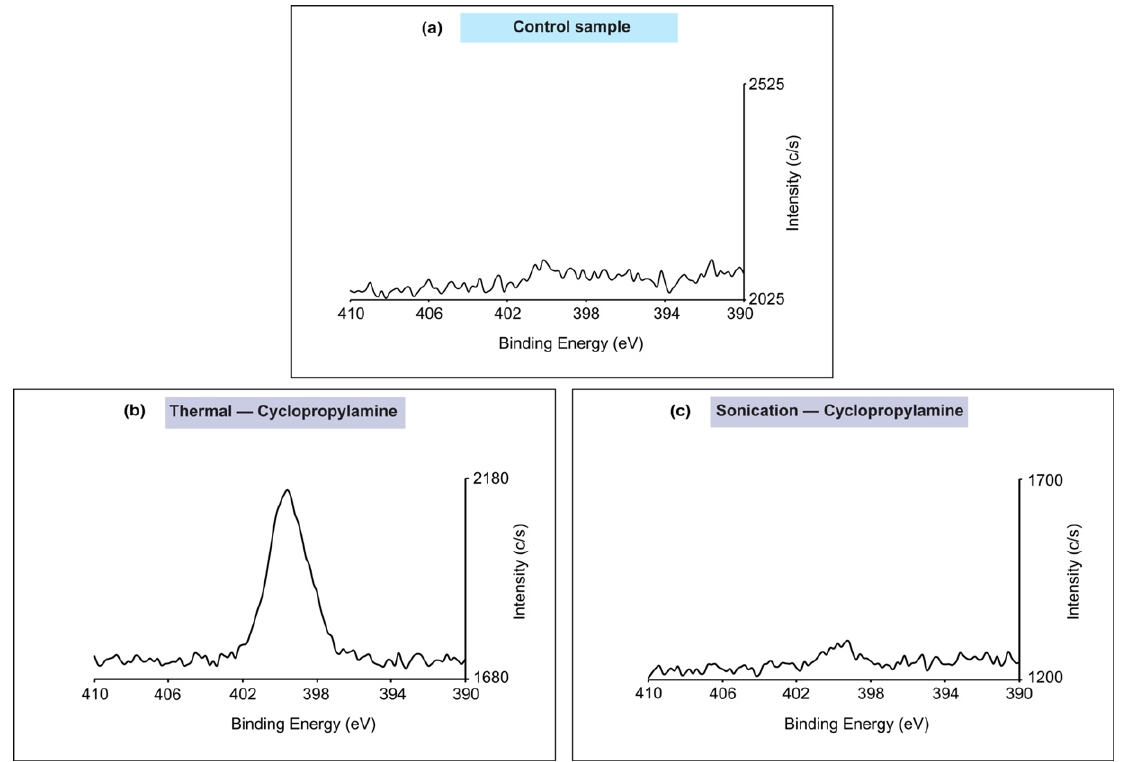
Figure 5. N1s spectra analysis for ( a ) control sample; ( b ) cyclopropylamine thermal reaction; ( c ) cyclopropylamine sonochemical reaction. Both samples ( a , c ) showed relatively flat spectrum while the thermal reaction of cyclopropylamine produced a significant peak at around 399 eV.